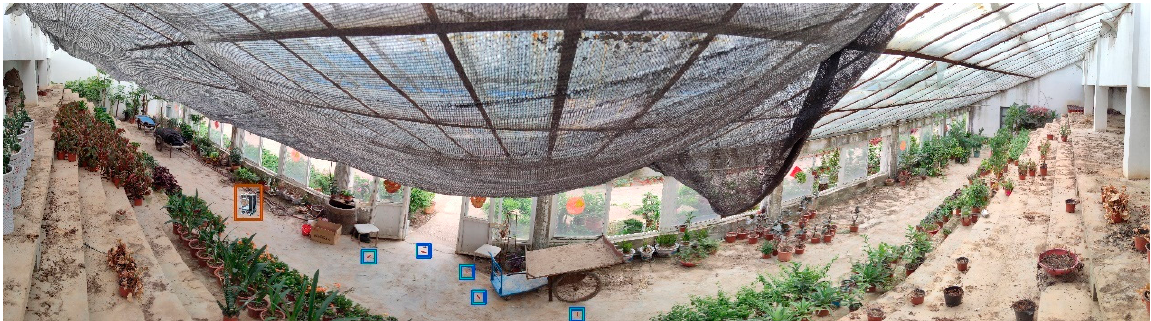
Figure 11. Real scene.